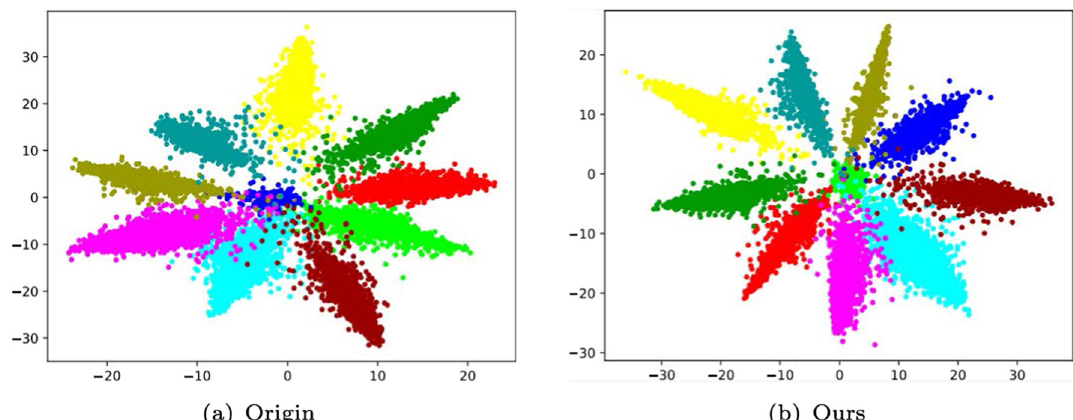
Fig. 5 The feature embedding of the original one(left) and our network(right) over the Cifar10 dataset, respectively